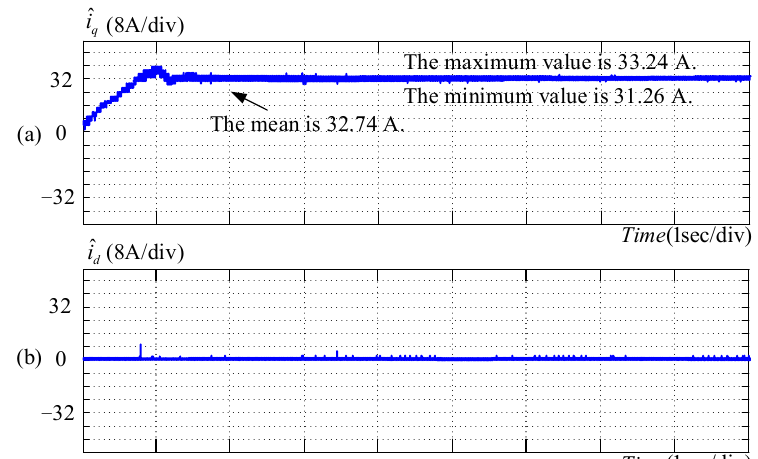
Figure 14. Measured q-axis and d-axis currents of a three-phase permanent-magnet synchronous motor driven at 1500 rpm with a compensation strategy for harmonic components in induced EMF along the q-axis and d-axis: ( a ) measured ˆ r q i ; ( b ) measured ˆ r d i .